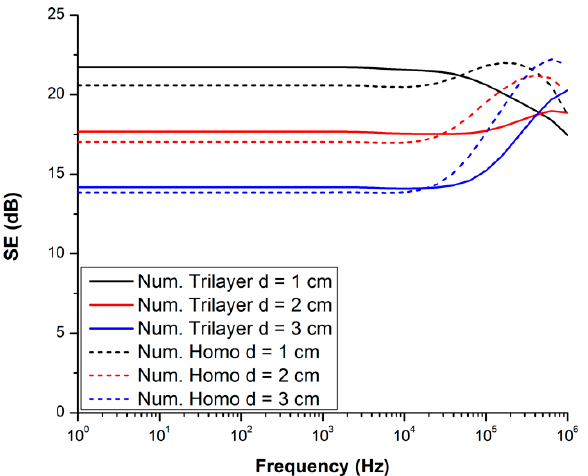
Figure 8. Shielding effectiveness of the trilayer composite (line) and the homogenized layer (dotted line) obtained numerically in near-field for different distances d with a sample radius of 10.5 cm.